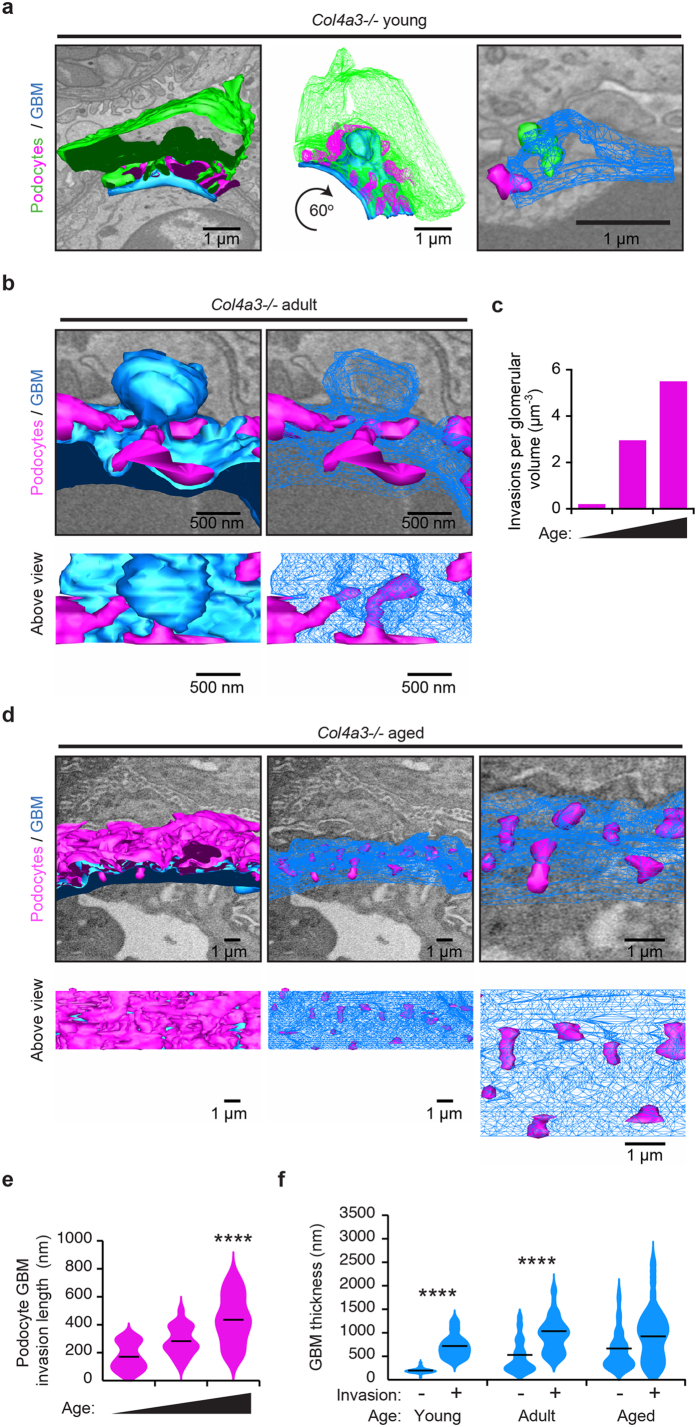
Analysis of podocyte FP invasions in Alport mice.(a) Reconstructed podocyte GBM interface in a young adult (6 week) Col4a3−/− mouse. Podocyte cell body (green) and FPs from a neighbouring podocyte (magenta) are shown. A rare example of two short podocyte FP invasions inside the GBM (blue) is shown in young Col4a3−/− mice (right hand panel). The GBM in this region in thickened relative to the rest of the GBM. (b) SBF-SEM reconstruction reveals two FPs invading an abnormally thickened area of GBM in an adult (16 week) Col4a3−/− mouse. (c) The number of FP invasions increase with age in Col4a3−/− mice. (d) FP invasions are frequent in aged (28 week) Col4a3−/− mice. The GBM is irregular in thickness, both thinned and thickened compared to young GBM. (e) Quantification of podocyte FP invasions. The violin plots describe the distributions for the length of podocyte invasion into the GBM along the y-axis, the black lines represent the mean length of podocyte GBM invasions in each group. (f) Quantification of GBM thickness at sites of podocyte invasion. The violin plots describe the distributions for the thickness of GBM at sites of podocyte invasion and sites where there is no podocyte invasion. The black lines represent the mean GBM thickness of each group. GBM, glomerular basement membrane; FPs, foot processes; *P < 0.05; ****P < 0.0001.